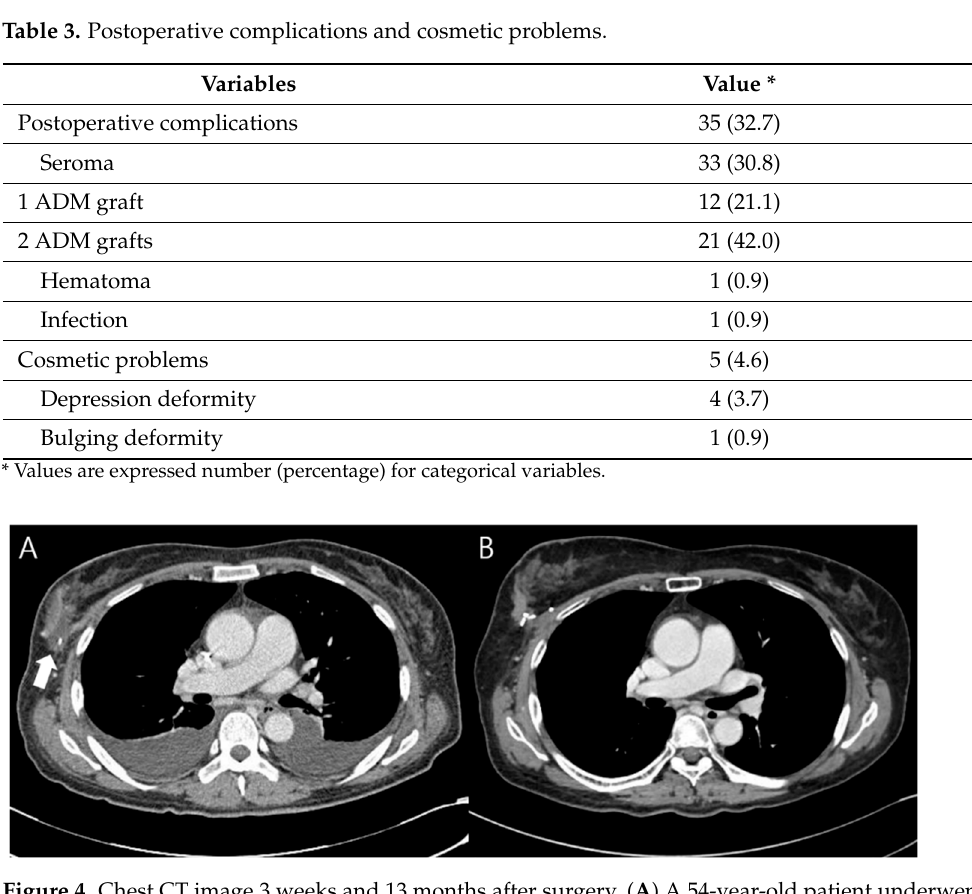
Figure 4. Chest CT image 3 weeks and 13 months after surgery. ( A ) A 54-year-old patient underwent breast reconstruction using the one ADM with the RBT after breast-conserving surgery. At 3 weeks after surgery, she complained of dyspnea during chemotherapy and a chest CT was taken. Seroma was noted on the chest CT (white arrow), and 5cc aspiration was performed, and was not observed when follow-up aspiration was performed 1 week later; ( B ) Seroma was no longer observed on the chest CT taken at 13 months after surgery.